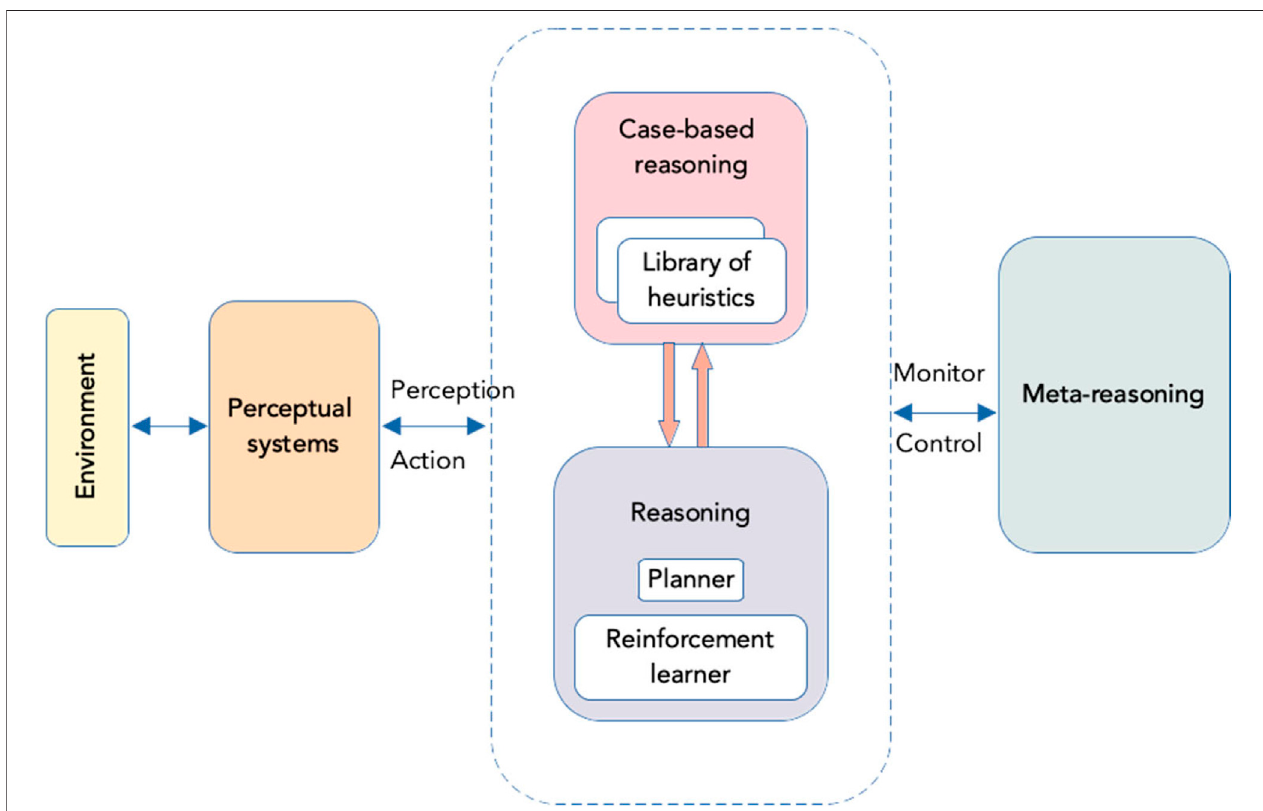
FIGURE 4 | System